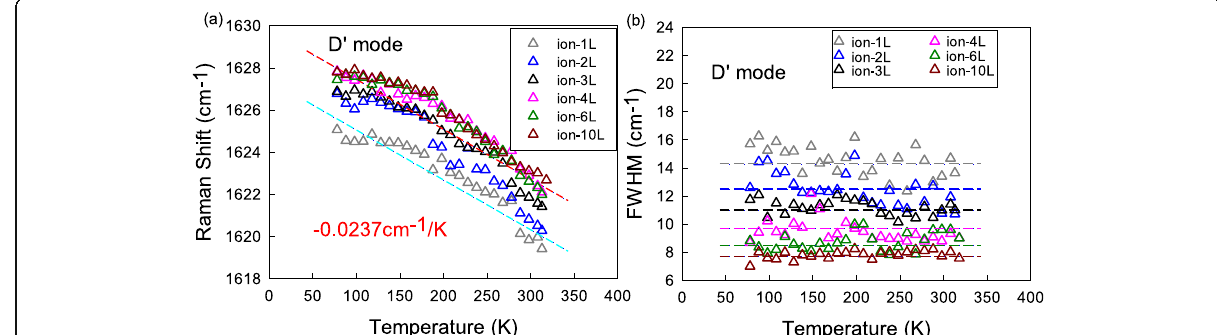
Fig. 5 The T-dependent a Pos(D ’ ) and b FWHM(D ’ ) of 1LG-4LG, 6LG, and 10LG for the defective set in the temperature range of 78 – 318